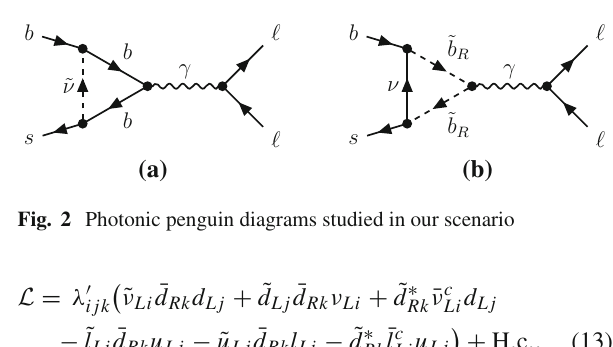
Fig. 1 Box diagrams for b → s μ + μ − transition in our scenario. a Shows an example ˜ W − b box diagram, b shows an example W − ˜ b R box diagram, c shows the H ± − ˜ b R box diagram, and d shows an example 4 λ (cid:4) box diagram